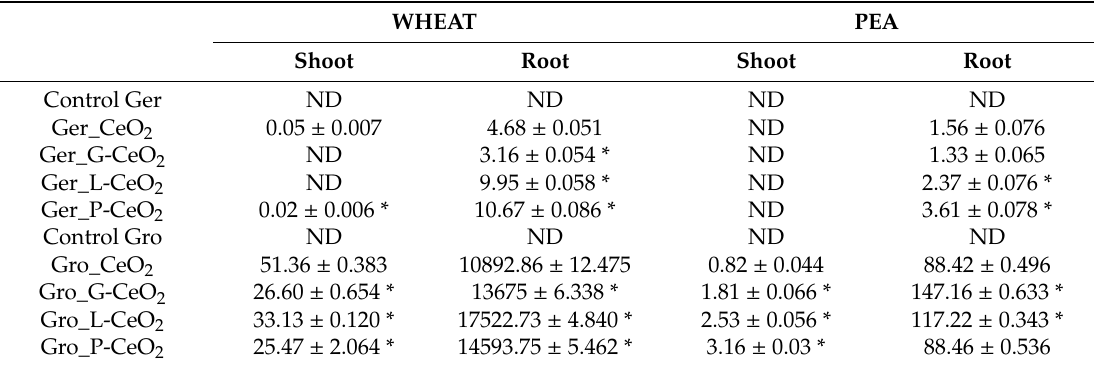
Table 2. Ce concentration (mg of Ce per kg of the dry mass of plant) in wheat and pea after germination (Ger) and three-week growth (Gro) treatments with di ff erent nCeO 2 at 200 mgL − 1 . WHEAT PEA Shoot Root Shoot Root Control Ger ND ND ND ND Ger_CeO 2 0.05 ± 0.007 4.68 ± 0.051 ND 1.56 ± 0.076 Ger_G-CeO 2 ND 3.16 ± 0.054 * ND 1.33 ± 0.065 Ger_L-CeO 2 ND 9.95 ± 0.058 * ND 2.37 ± 0.076 * Ger_P-CeO 2 0.02 ± 0.006 * 10.67 ± 0.086 * ND 3.61 ± 0.078 * Control Gro ND ND ND ND Gro_CeO 2 51.36 ± 0.383 10892.86 ± 12.475 0.82 ± 0.044 88.42 ± 0.496 Gro_G-CeO 2 26.60 ± 0.654 * 13675 ± 6.338 * 1.81 ± 0.066 * 147.16 ± 0.633 * Gro_L-CeO 2 33.13 ± 0.120 * 17522.73 ± 4.840 * 2.53 ± 0.056 * 117.22 ± 0.343 * Gro_P-CeO 2 25.47 ± 2.064 * 14593.75 ± 5.462 * 3.16 ± 0.03 * 88.46 ±